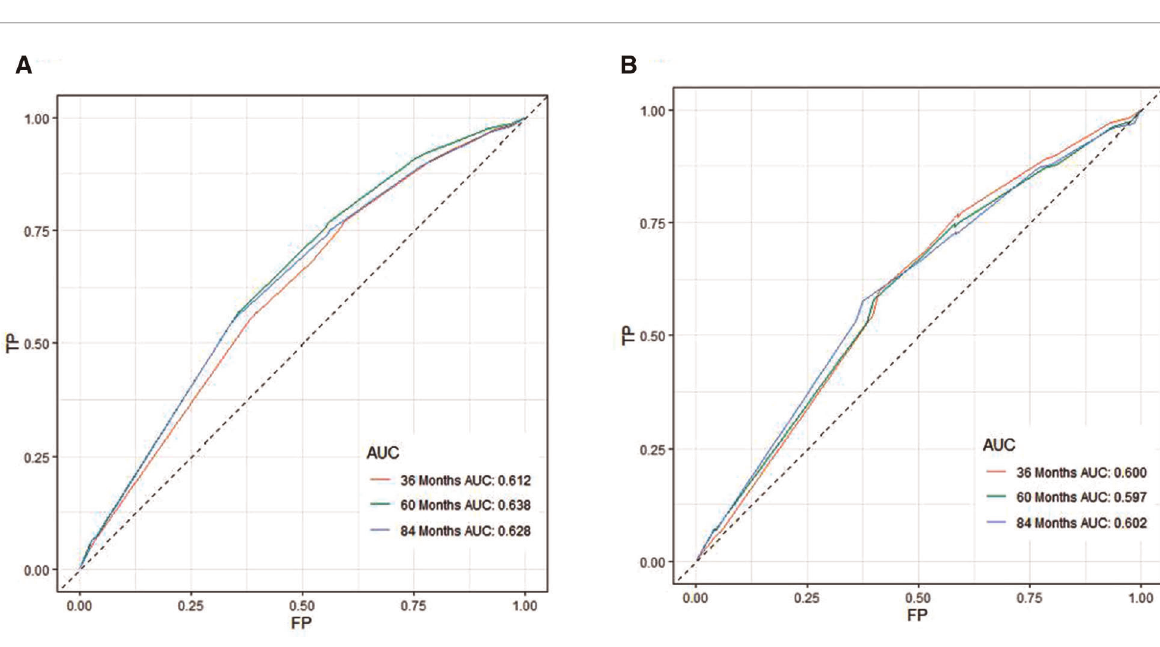
FIGURE 3 ROC curves for CSS prediction of patients receiving neoadjuvant chmoradiotherapy. ( A ) ROC curves of 3-, 5-, and 7-years in the training cohort, ( B ) ROC curves of 3-, 5-, and 7-years in the validation cohort. TP, True positive rate; FP, false positive rate; ROC, Receiver operating characteristic; CSS, cancer-speci fi c